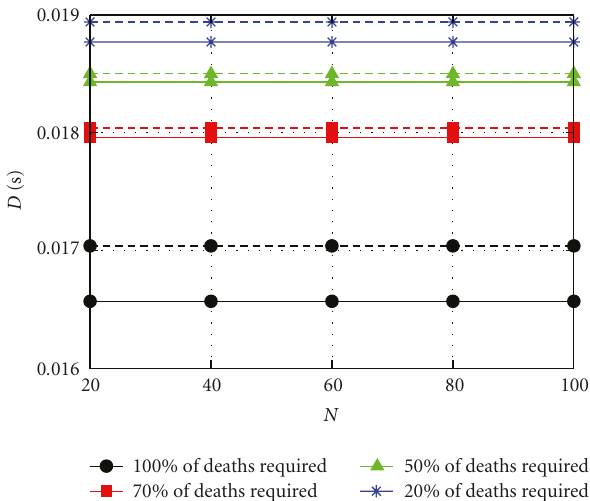
Figure 17: Average MAC delay D , as a function of the number of sensors N , in a ZigBee wireless sensor network with nodes’ failures. Two possible distributions for a single sensor lifetime are consid- ered: (a) exponential with μ = 300 seconds (solid lines) and (b) uniform with t max = 600 seconds (dashed